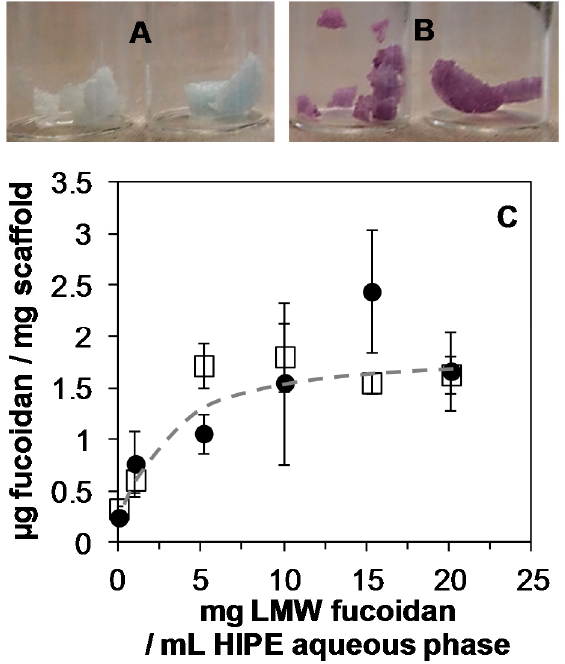
Figure 2. A,B: Sca ff old staining (after washing) due to complexation of toluidine blue with LMW fucoidan for the fucoidan concentration in the HIPE aqueous phase (34 mL) of 0 mg mL − 1 ( A ) and 10 mg mL − 1 ( B ). C : Amount of LMW fucoidan immobilized inside sca ff olds before ( (cid:3) ) and after washing ( (cid:8) ) as a function of the LMW fucoidan concentration in the HIPE aqueous phase.